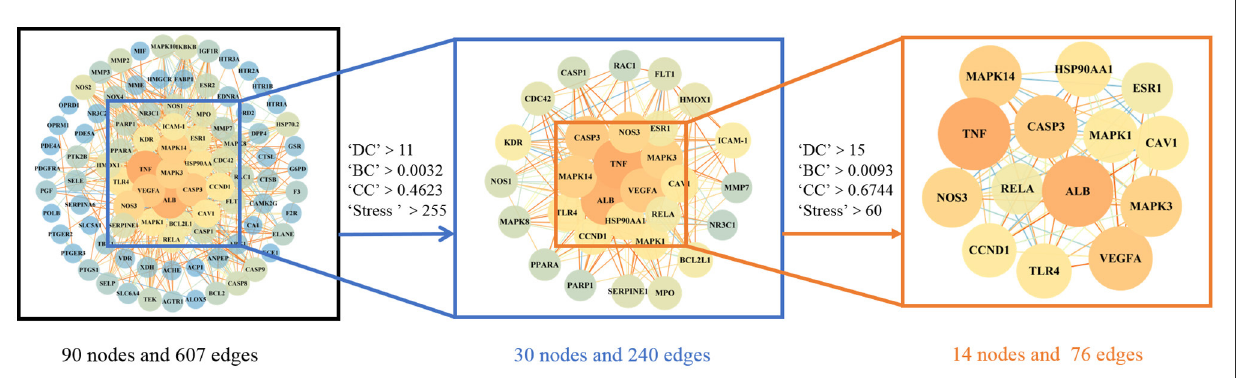
FIGURE4 The topology screening process of the protein interaction network. The node size and color were related to the degree value. The color and size of the node are adjusted in accordance with the degree value. The darker colors and larger nodes indicate a larger degree value.